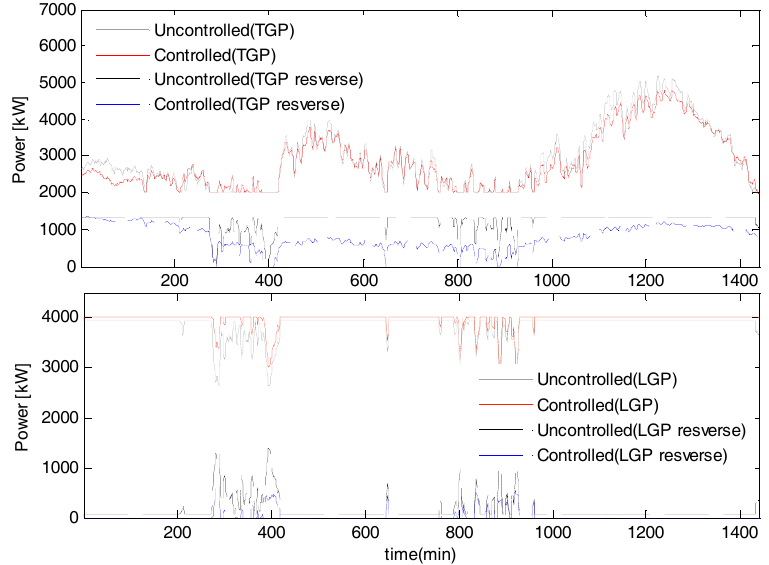
Figure 8. Power generation and reserve capacity of a TGP and LGP for the controlled and uncontrolled cases.